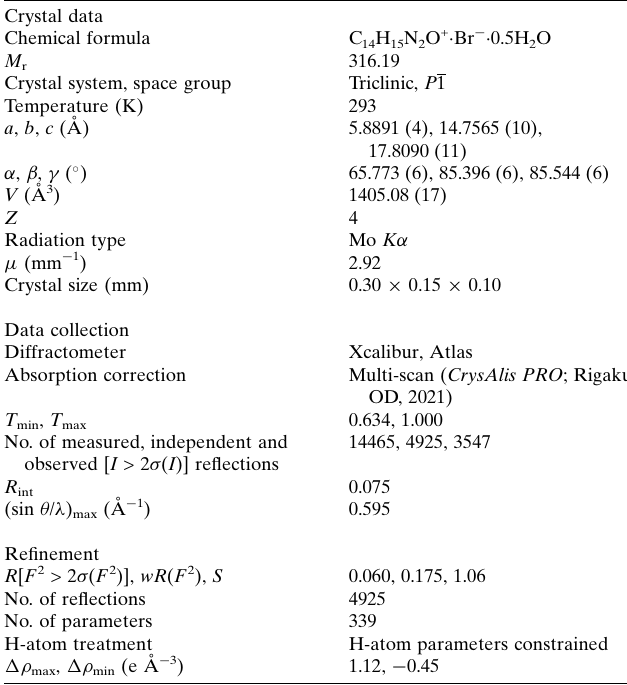
Table 4 Experimental details. Crystal data Chemical